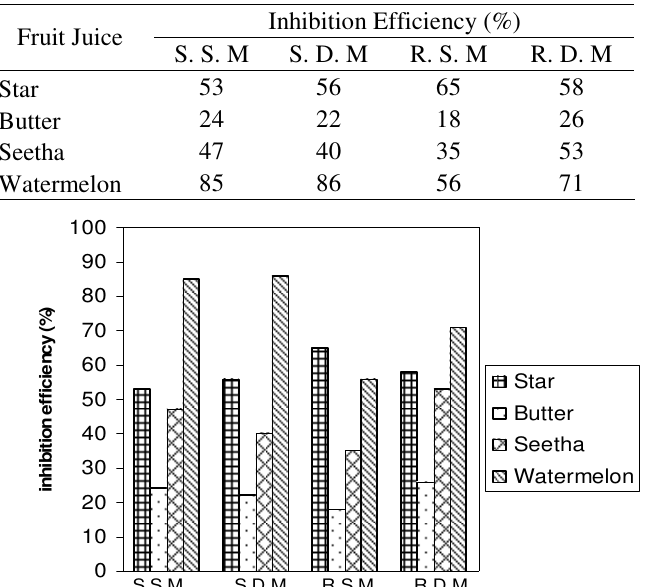
Table 1. Inhibition of calcium oxalate mineralization by fruit juice